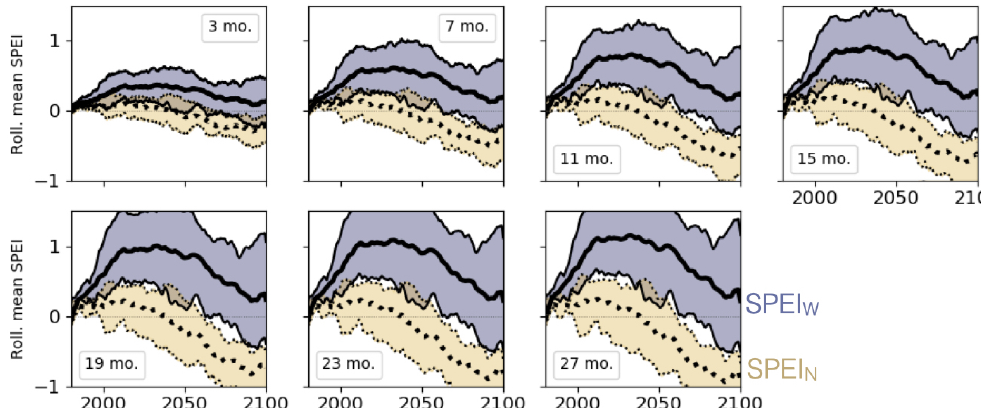
Figure B1. Comparison of glacial effect on the SPEI over the 21st century when the SPEI is computed with integration timescales ranging from 3 to 27 months, shown for the Tarim basin as an example. The upper left panel shows the 3-month integration timescale presented in the main text. Color scheme and axes are consistent with Fig. A1.